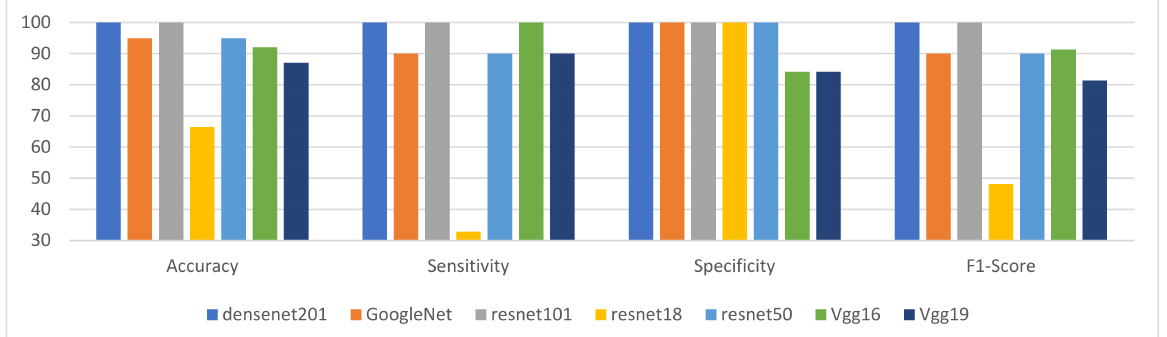
Figure 6. Comprehensive view on INbreast dataset of the effect of the different CNN models using best value of